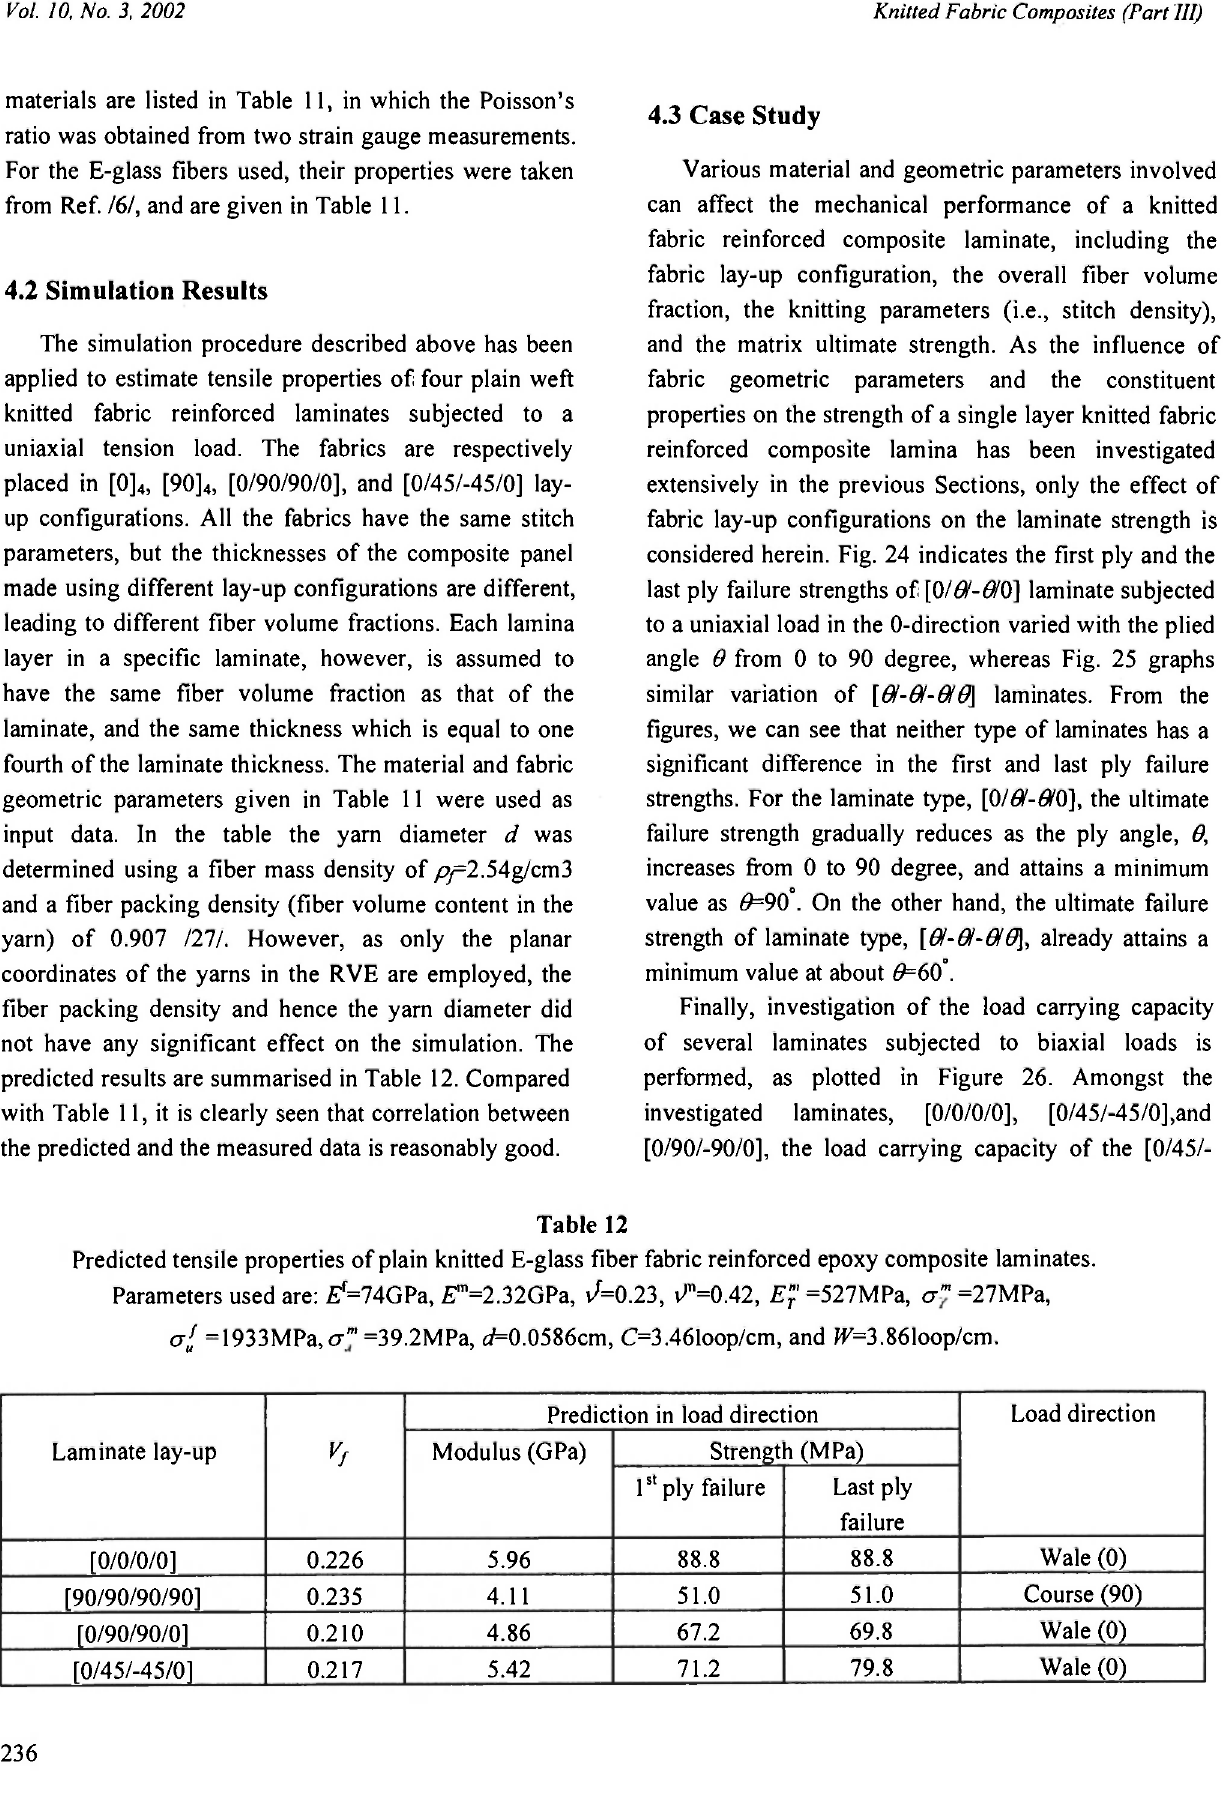
Predicted tensile properties of plain knitted Ε-glass fiber fabric reinforced epoxy composite laminates. Parameters used are: £ f =74GPa, £ m =2.32GPa, ^=0.23, ^"=0.42, E" r ' =527MPa, σ"